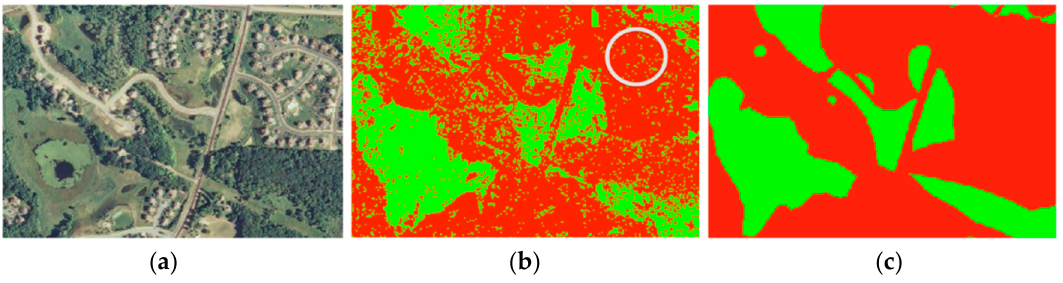
Figure 4. Spatial Classification Problem [6]. ( a ) input high-resolution aerial imagery, Chanhassen, Minnesota, USA; ( b ) decision tree prediction with salt-and-pepper errors highlighted in white circle; ( c ) ground truth class map: red is dry land and green is wetland.